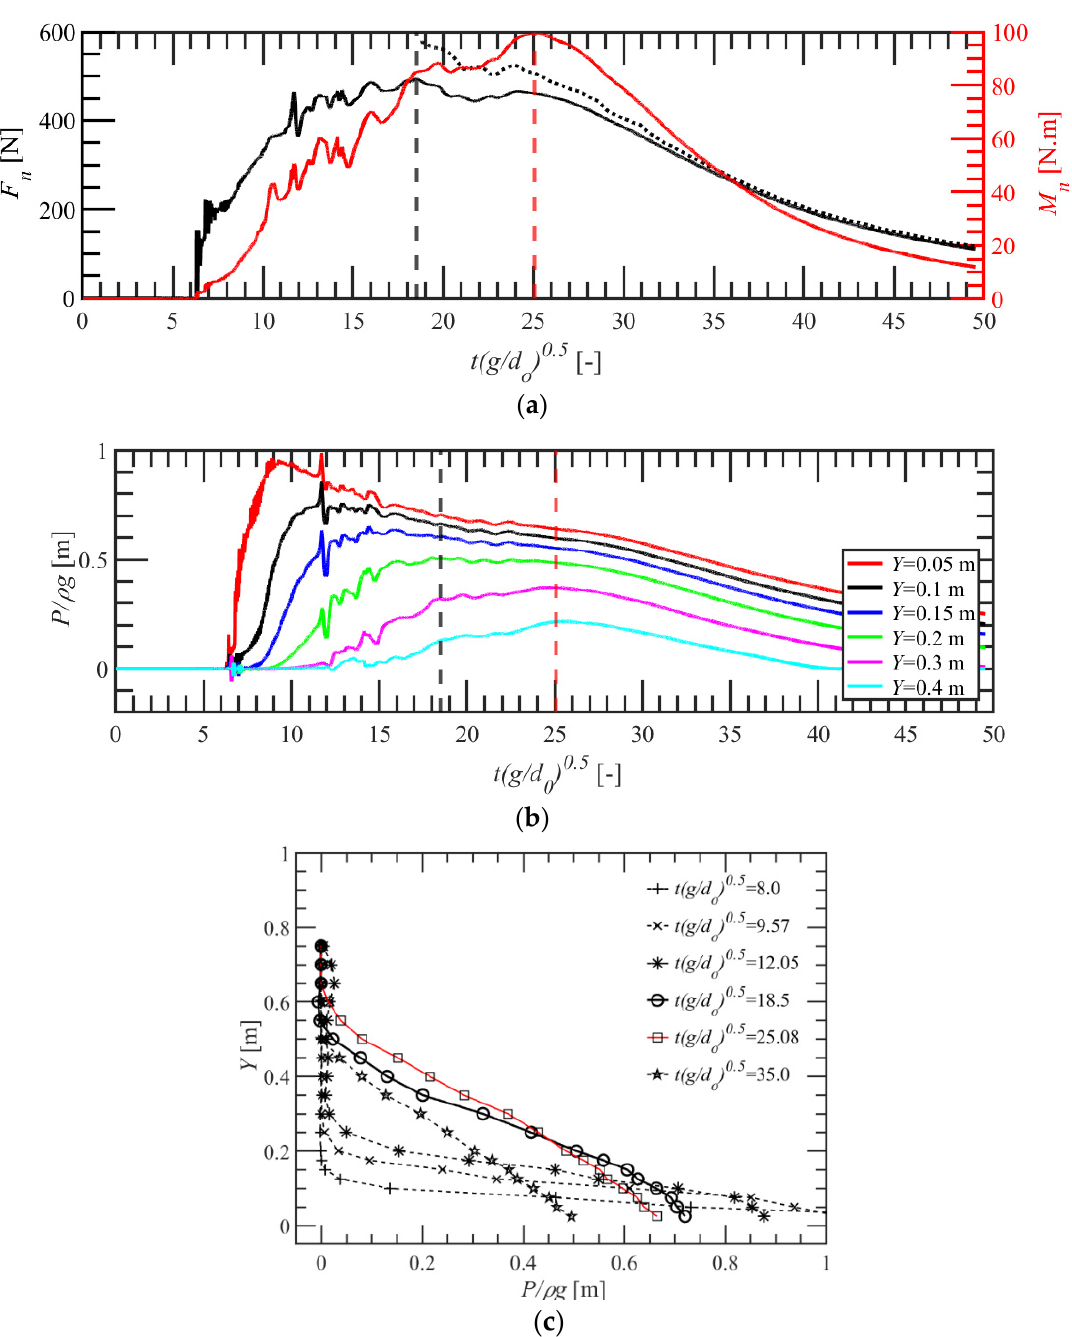
Figure 6. Force, overturning moment and pressure characteristics in the absence of a mitigation wall for d o = 0.9 at X = 10 m: ( a ) force and moment–time history (black solid line, force; black dotted line, calculated hydrostatic force; red solid line, overturning moment; dashed lines indicate the time at peak); ( b ) pressure time history at different levels from the structure bottom at the structure center; ( c ) pressure distribution at different time steps (solid line-at F n,max (black) and M n,max (red)).